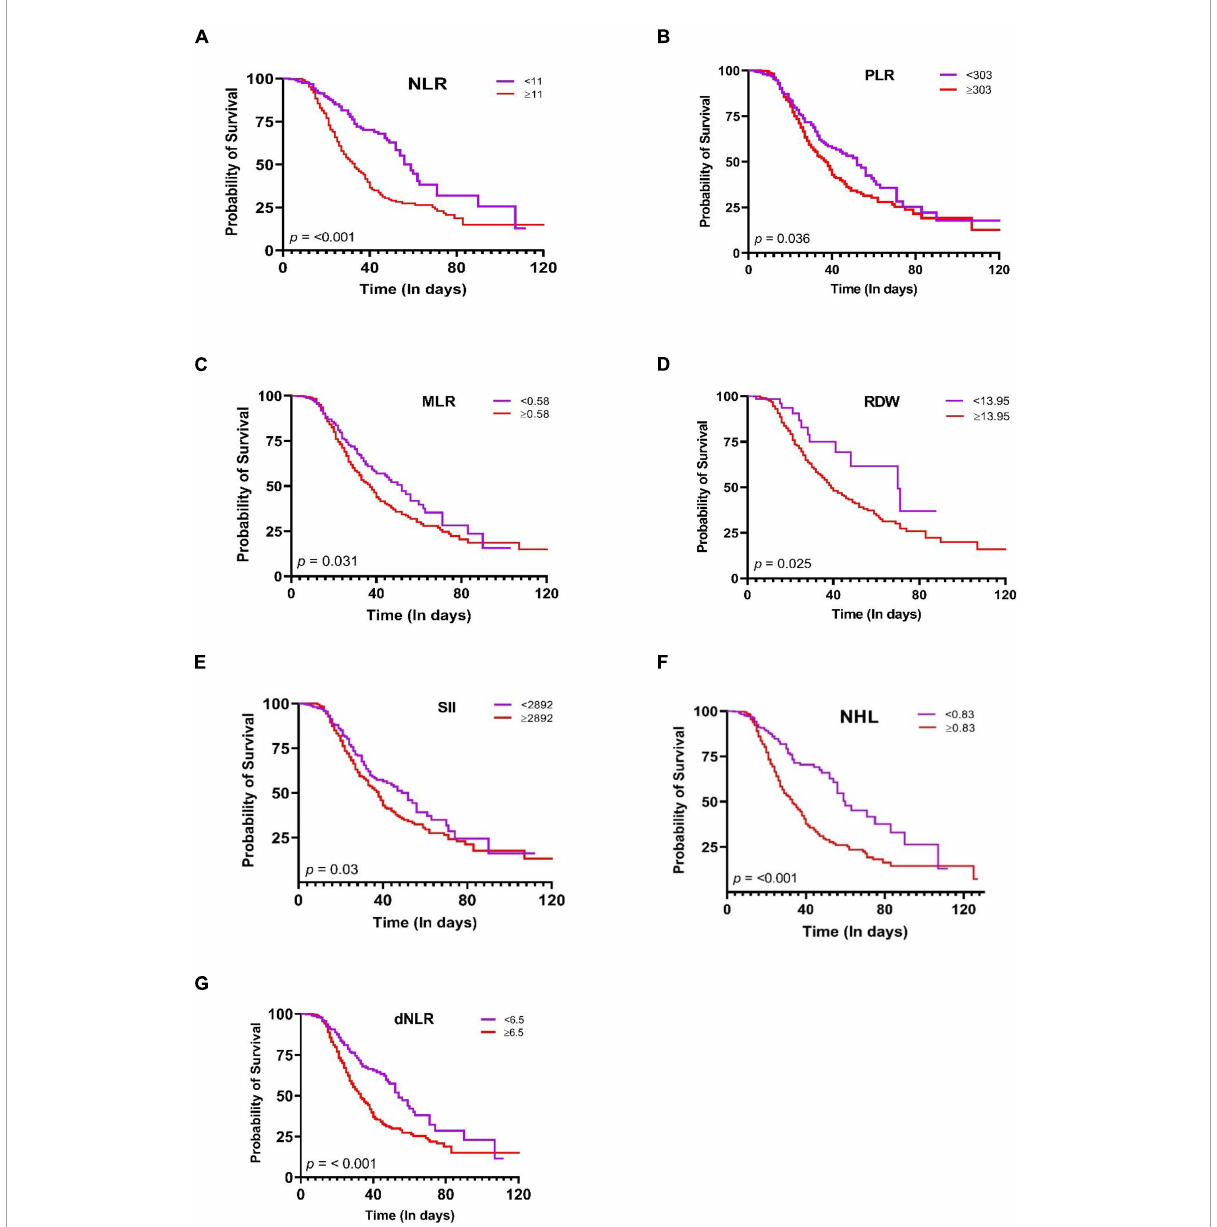
FIGURE3 Kaplan–Meier survival curves during hospitalization of COVID-19 in Mexican patients with different cut-off values of the systemic inflammation indices. (A) NLR, (B) PLR, (C) MLR, (D) RDW, (E) SII, (F) NHL, (G) dNLR. Statistical analyses were performed by Kaplan-Meier method and compared using the Log-rank test. Significance was set at p -value <